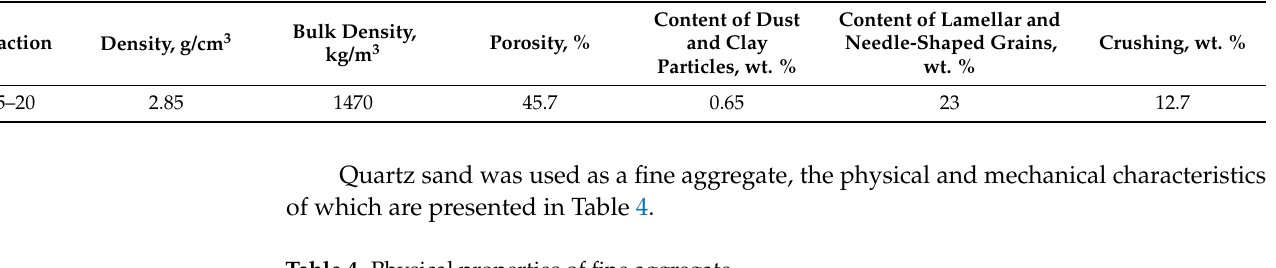
Table 4. Physical properties of fine